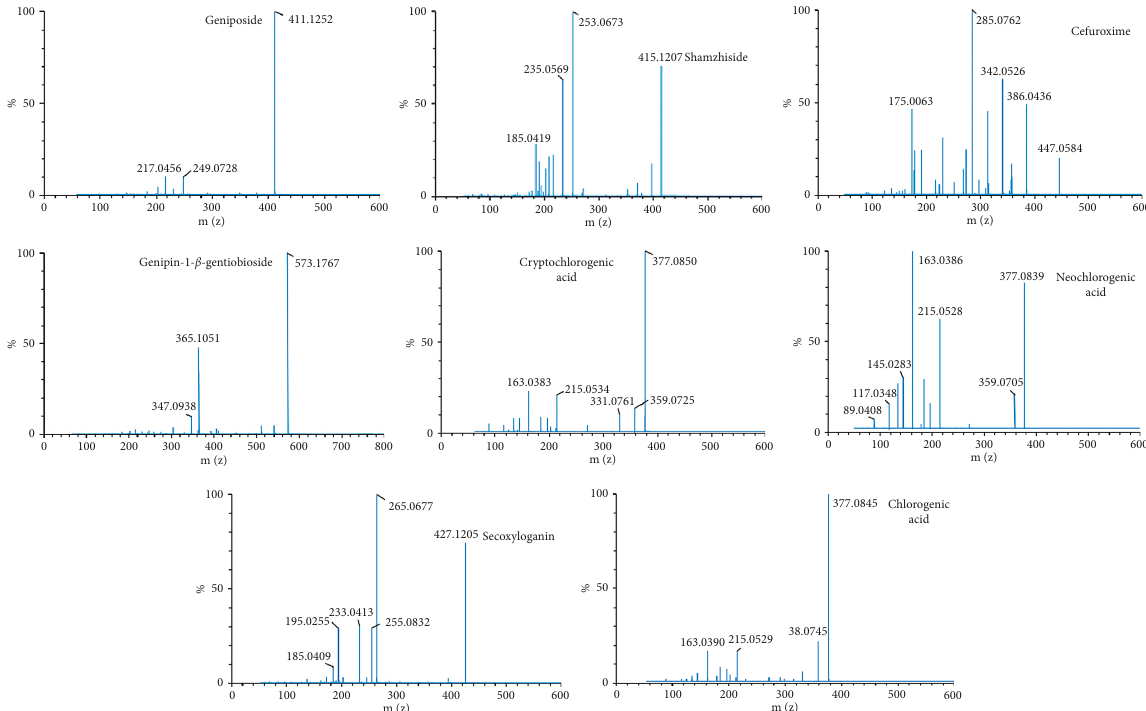
Figure 2: The mass spectrum of seven ingredients of RDN and